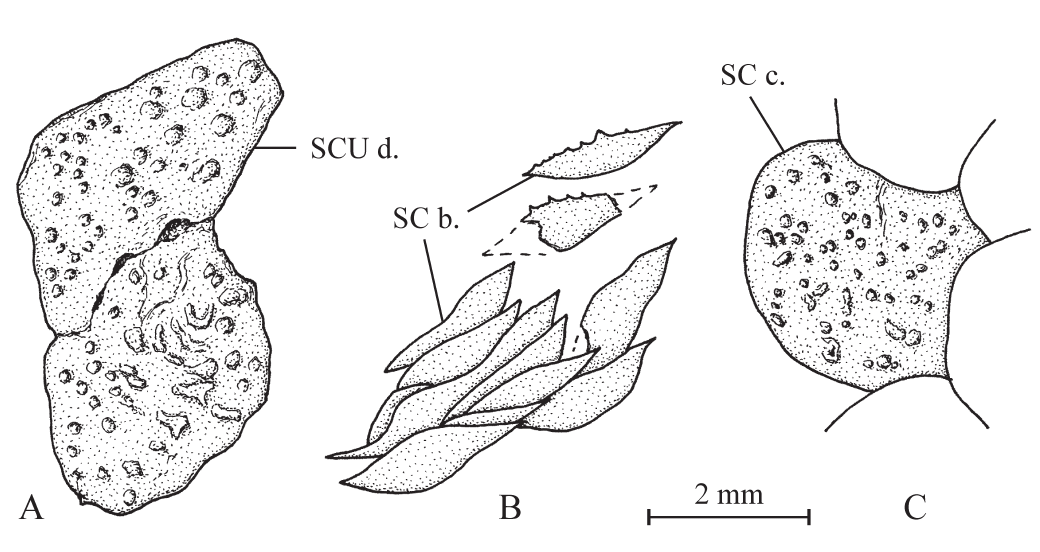
Fig. 6. Gladiopycnodus karami gen. et sp. nov., holotype CLC S-393. A . First dorsal scute. B . Some scales of the body. C . One scale near the caudal